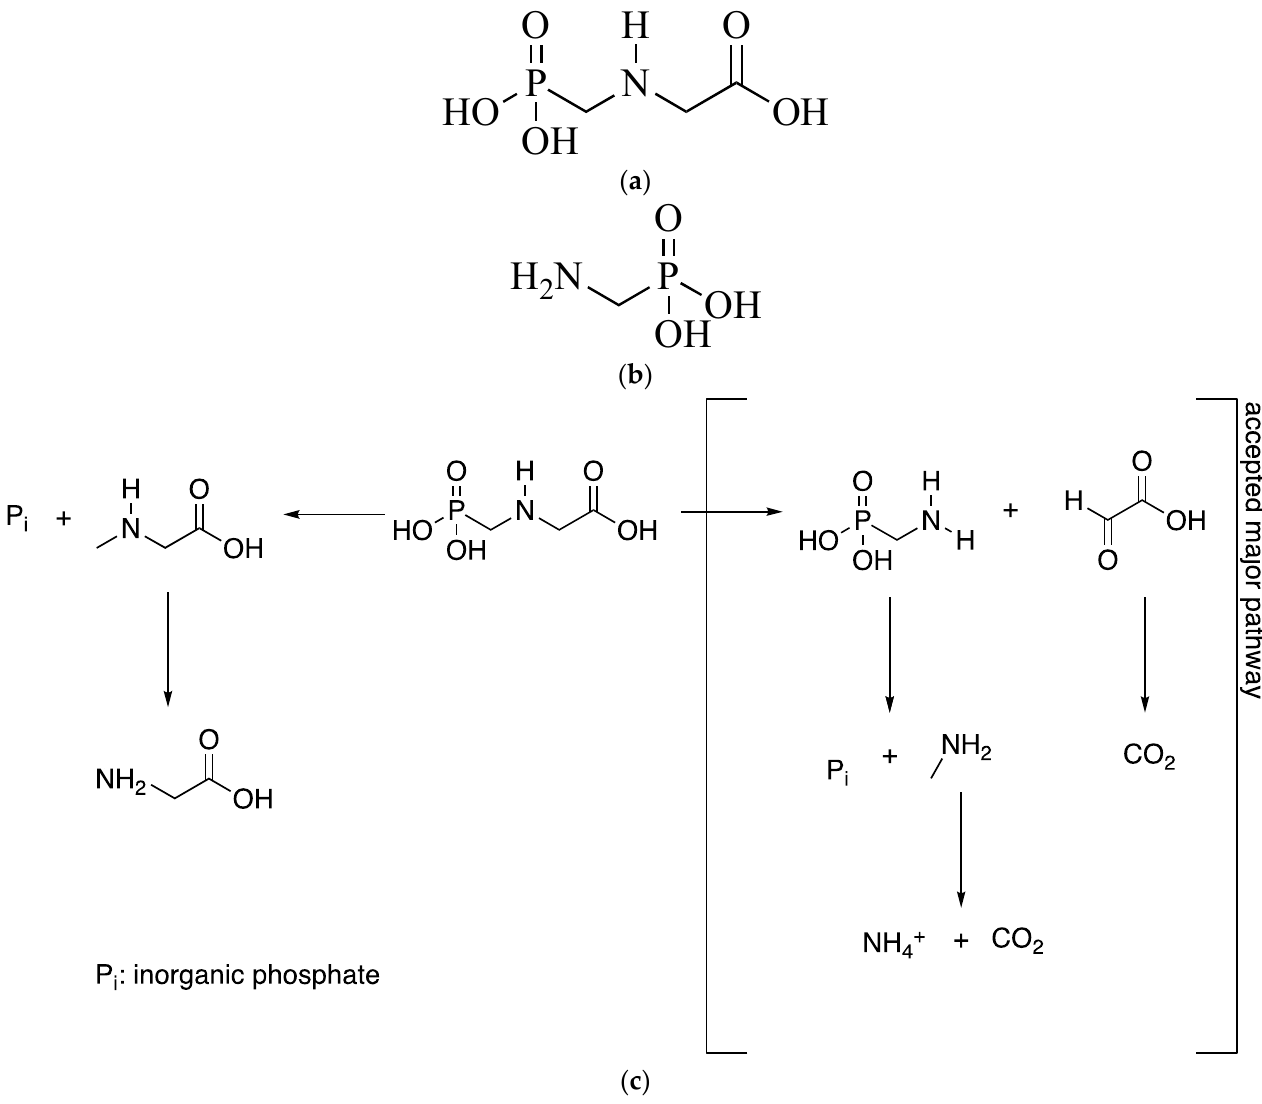
Figure 1. Structural formula of glyphosate ( a ) and AMPA –(aminomethyl)phosphonic acid– ( b ), together with degradation pathway for glyphosate in soil ( c ).